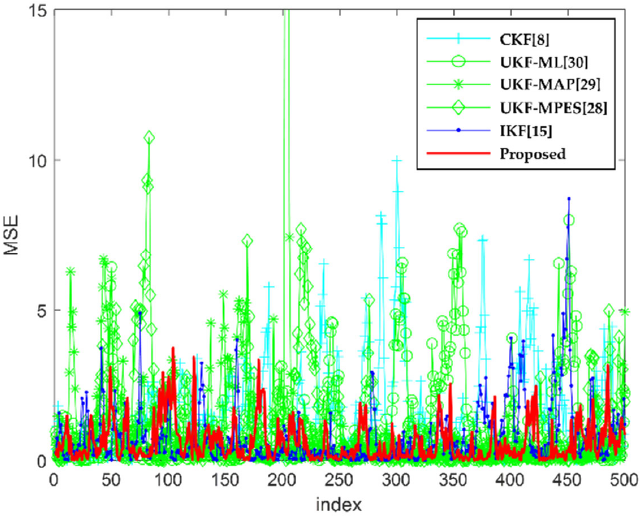
Figure 4. The MSE of each filter.